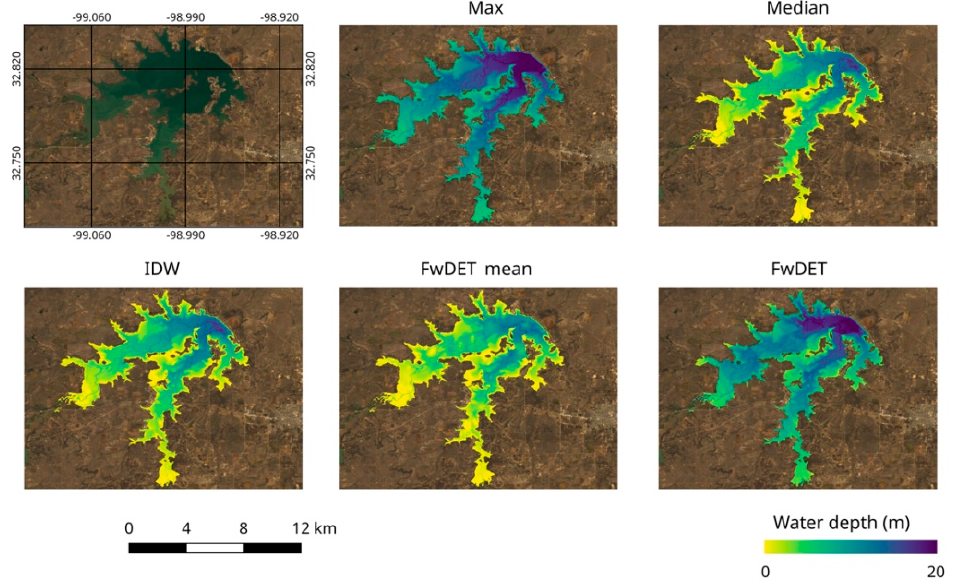
Figure 12. Hubbard Creek lake satellite image taken on 15 February 1991 and the different water depth maps obtained using the different methodologies.